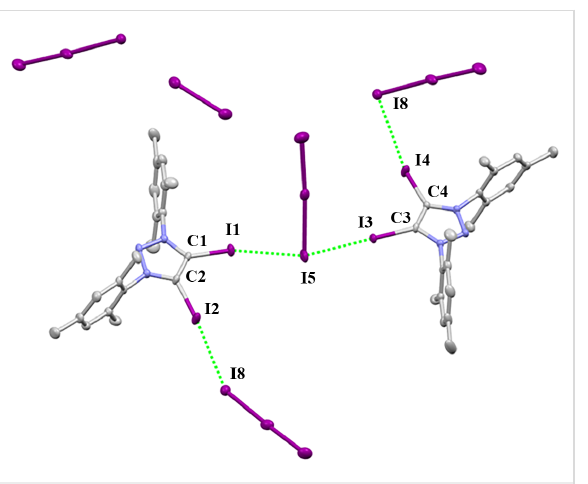
Figure 6: Packing structure of 2-I . 1.5I 2 . Hydrogen atoms have been omitted for clarity.